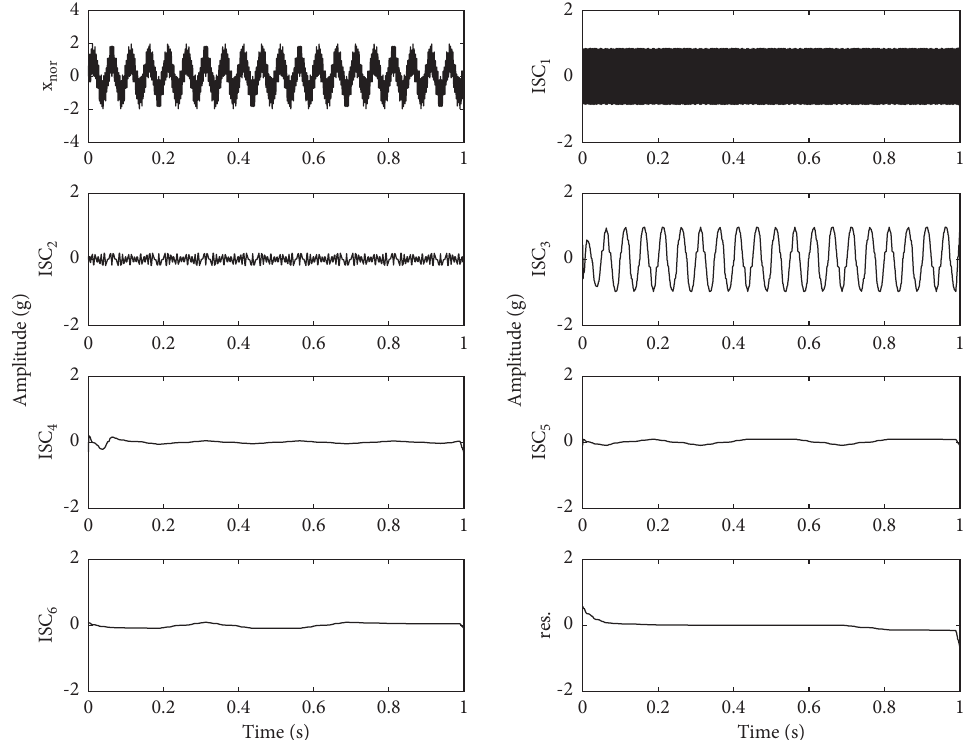
Figure 3: LCD decomposition results of x-channel under normal